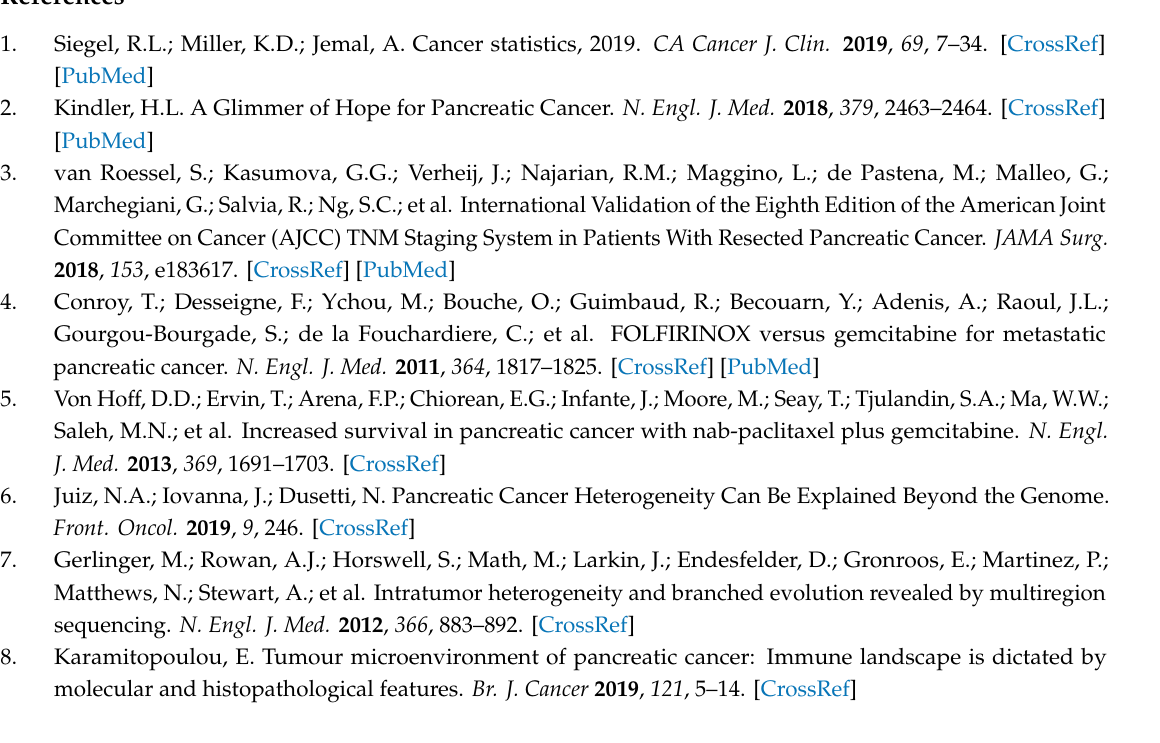
Table S1: Clinical characteristics of patients in training and validation datasets, Table S2: Class comparison analysis between normal pancreas and pancreatic tumour tissues, Table S3: Annotation of the PAC-5 genes, Table S4: Association between the PAC-5 signature and Mo ffi tt classification, Table S5: Information of chemotherapeutic drug names and treatment in validation datasets, Table S6: Methylation of the PAC-5 genes, Table S7: List of protein–protein interaction